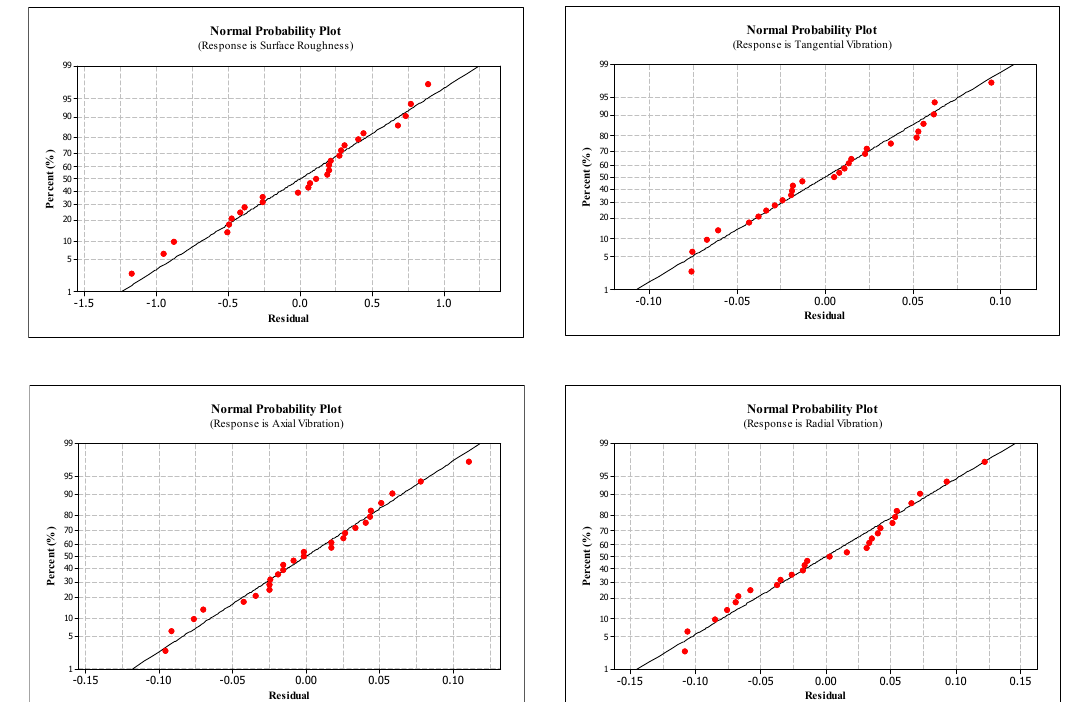
Figure 5. Normal probability plots for surface roughness and vibration.